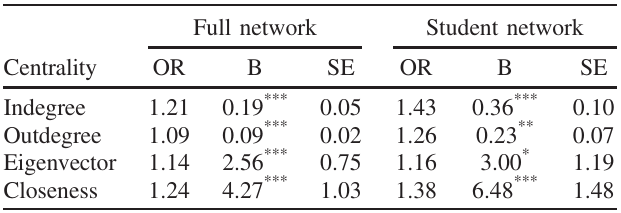
TABLE V. Logistic regression results for in- and out-of-class centralities. Odds ratio (OR), coefficient estimates (B), and standard error (SE) for the simple logistic regression for persist- ence as predicted by various in-class and out-of-class centrality measures for the third collection — the collection in the middle of the term. Significant adjusted P values are marked with an